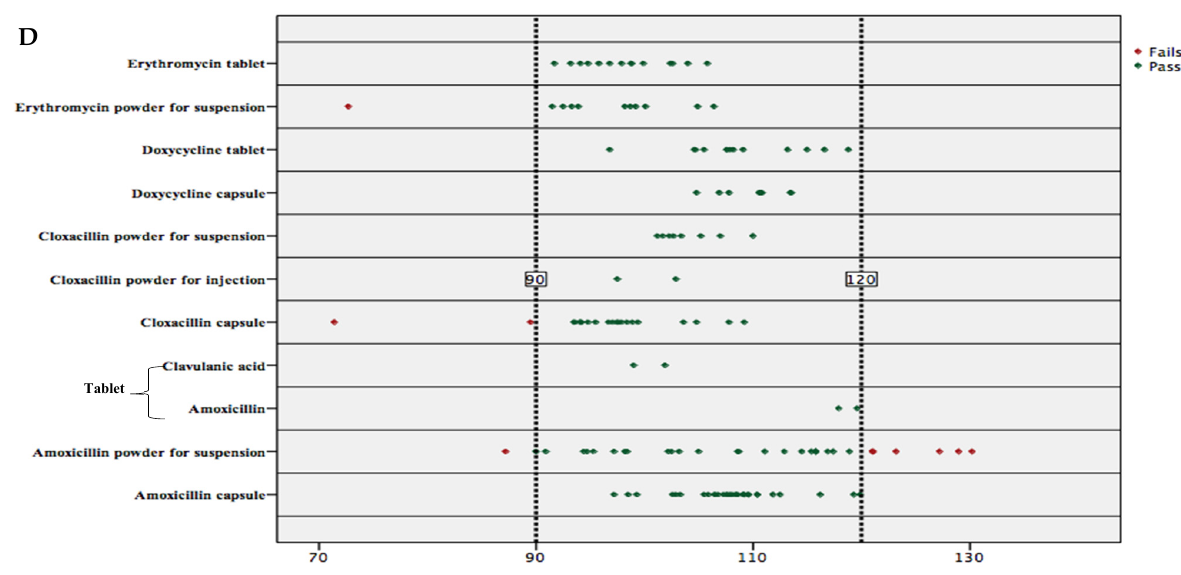
Figure 2. Percentage API content by batches according to different acceptance ranges as defined by the USP for each analyzed antibiotic, ( A ) 90–110, ( B ) 93–107, ( C ) 90–115 and ( D ) 90–120. Each point represents a batch, but one point (batch) of amoxicillin powder for oral suspension is hidden by another batch which scored a close result for the same antibiotic (121.0% and 121.1%).